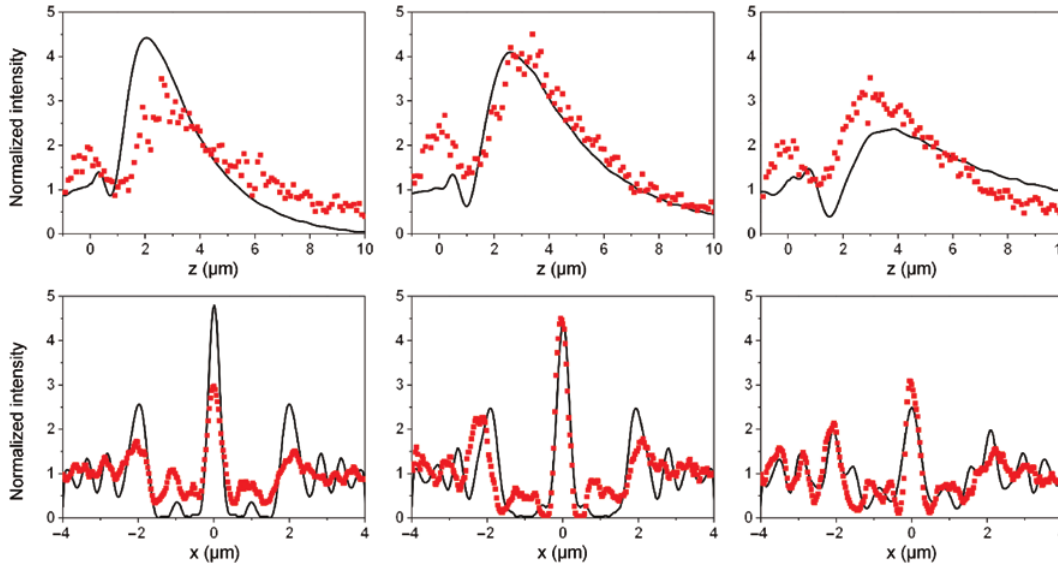
Figure 8: First and second rows: intensity distributions along the longitudinal focal axis (x = 0, z), and intensity distributions along the lateral focal axis (x, z = Z ). f Solid lines for FEM simulations. Dotted lines for experimental data after deconvolution. Left, middle and right columns are for RGB color splitting, respectively.